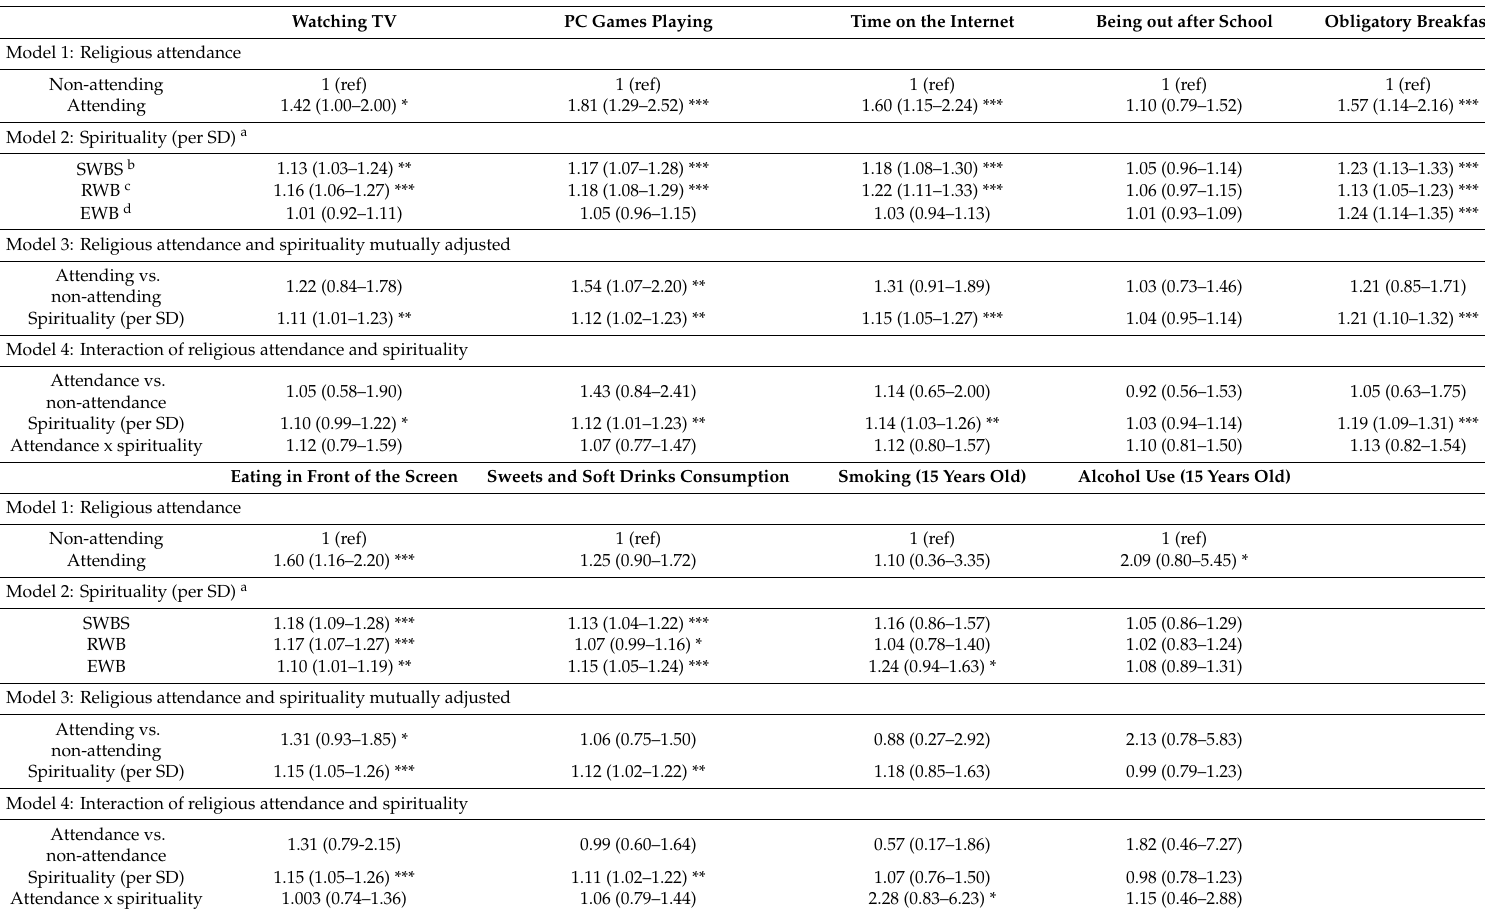
Table 4. Associations of adolescent parental monitoring (control of behaviour) with religious attendance and spirituality (standardized to z-scores), adjusted for age, gender and socioeconomic status (odds ratios and 99% confidence intervals).